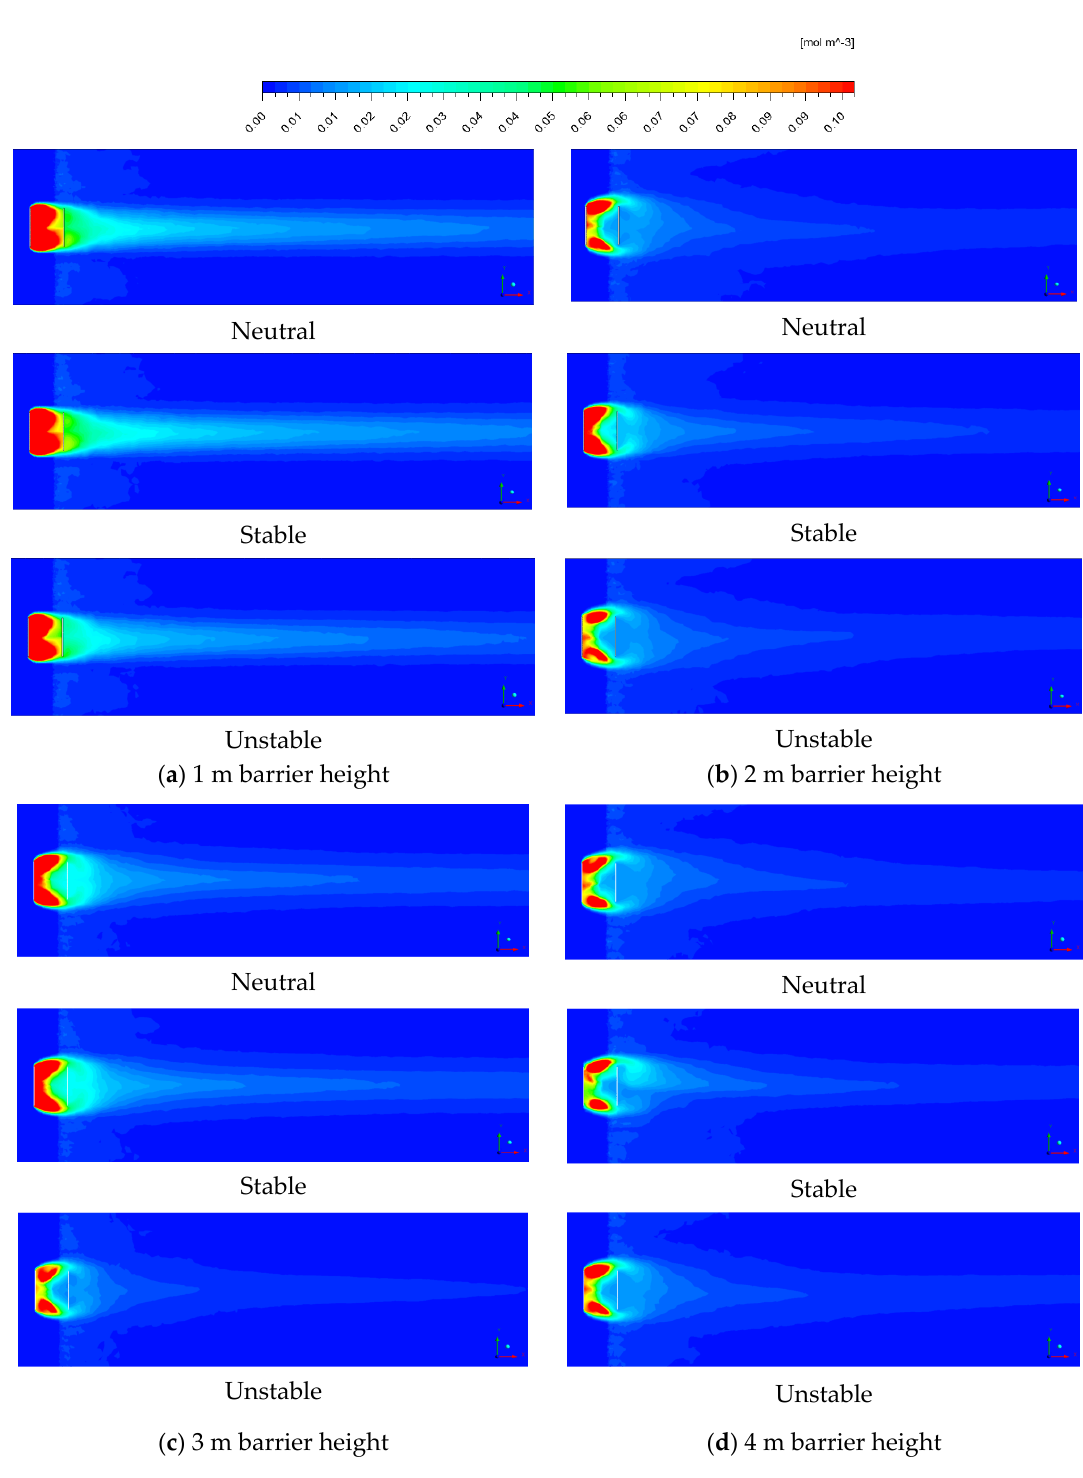
Figure 16. Ground level (Z = 1 m) CO 2 concentration for with edge effects under various thermal conditions for various noise barrier height.